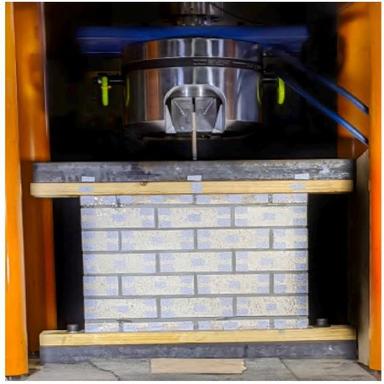
Tensile test setup with horizontal brick specimen.